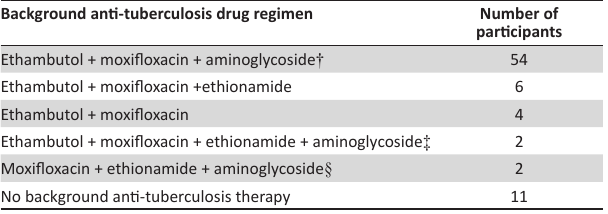
TABLE 2: Background anti-tuberculosis drug regimens prescribed following anti-tuberculosis drug-induced liver injury.